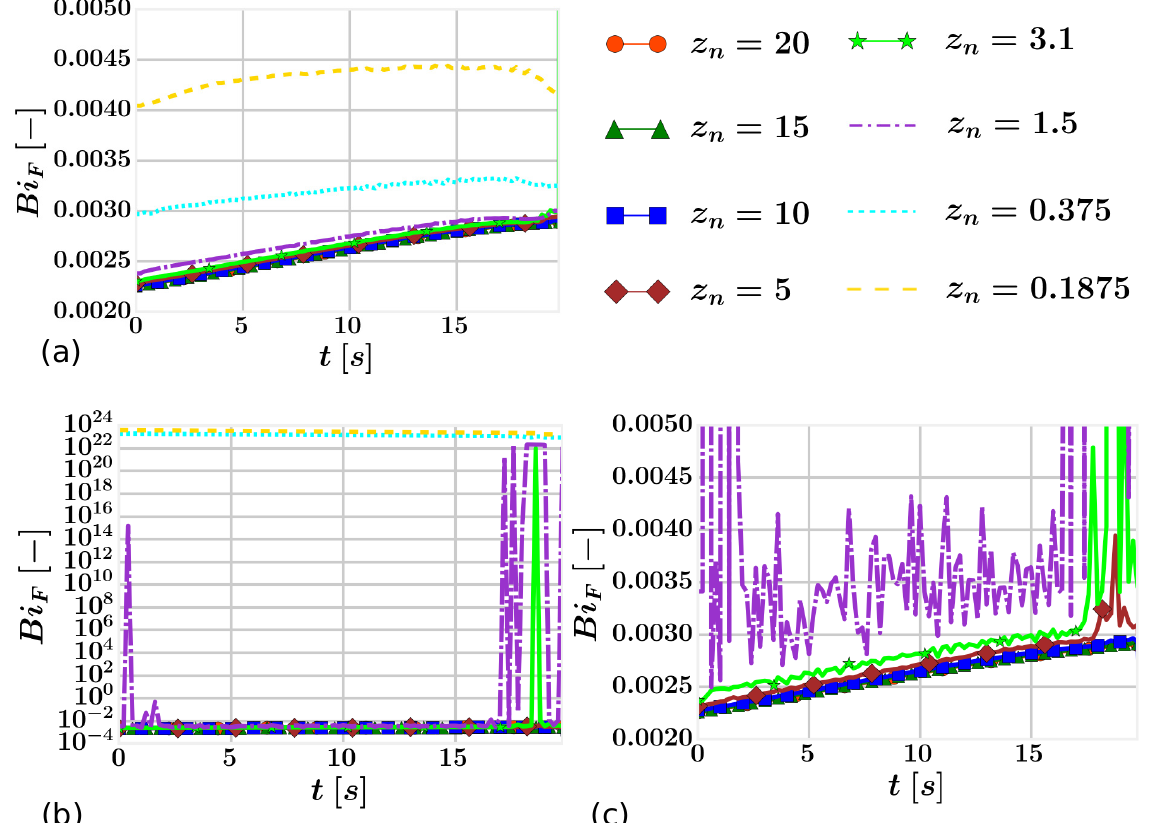
Figure 7. Fluid Biot number according to Equation (38) using various fluid meshes. The interfa- cial phase change is not activated. ( a ) Location L 1; ( b ) Location L 3; ( c ) Location L 3 focused on z n ≥ 1.5